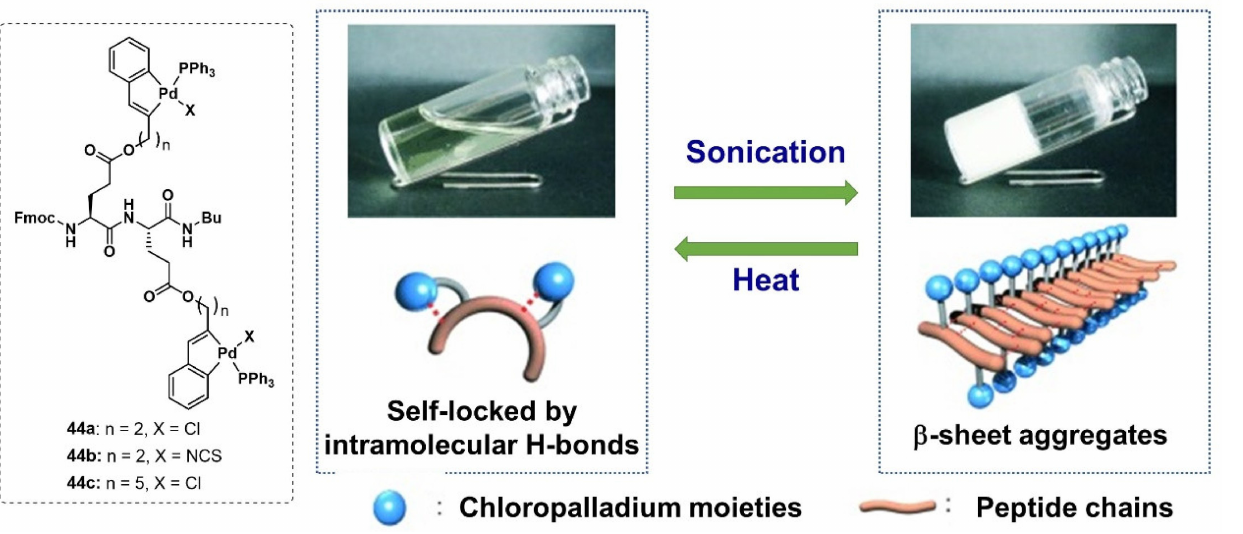
Figure 19. The molecular structure of metalated peptides 44a and reversible gelation of a 1.50 × 10 − 2 M solution of 44a in EtOAc at 25 ◦ C. The solution is shown before and just after sonication (0.45 Wcm − 2 , 40.0 kHz, 60 s). Reprinted with permission from Ref. [82]. Copyright (2007), John Wiley and Sons.